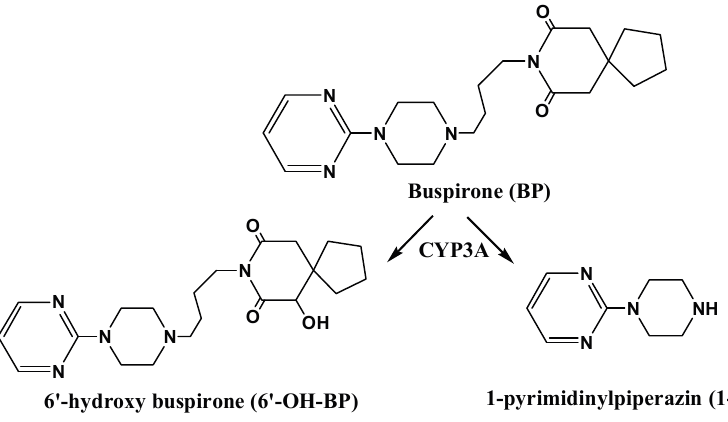
Figure 2. The major metabolic pathways of buspirone